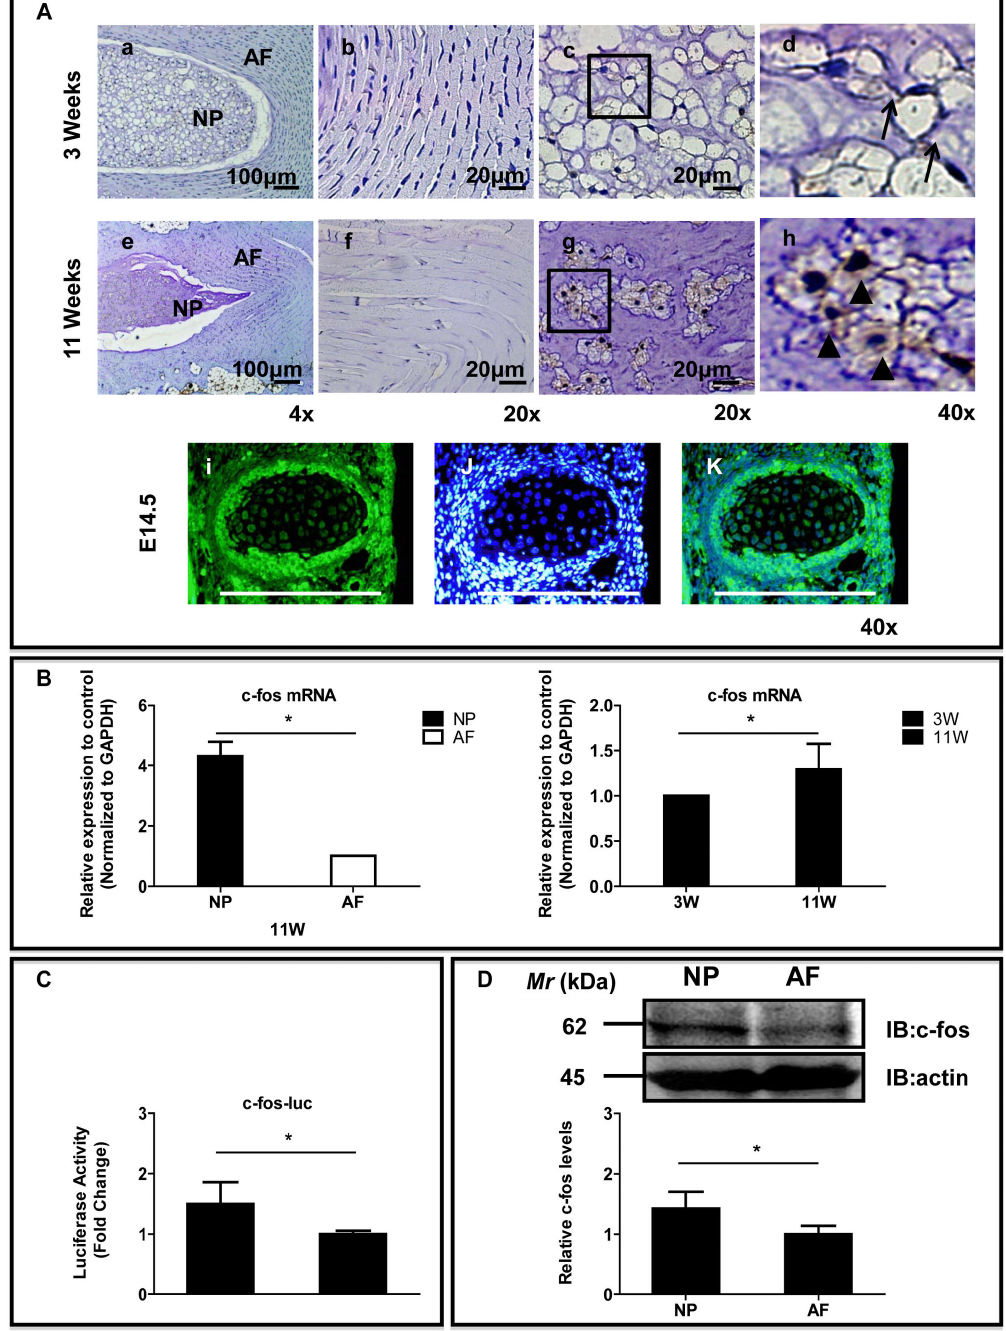
Figure 3. The expression of c-fos in IVD. ( A ) Sagittal sections from 3-week-old ( a - d ), 11-week-old ( e - h ) rats and a mouse embryo (day 14.5 of gestation). Detection of c-fos expression by immunofluorescence microscopy. b and f : AF, c- d and g- h : NP, i- k : notchordal cell of embryonic mouse ( Left : The cells stained with antibody to c-fos. Middle : The cells were stained with DAPI to identify healthy nuclei, shown in blue. Right: The cells were stained with an antibody to c-fos and with DAPI). Scale bar= 20 μm-100 μm (original magnification 4×- 40×). ( B ) Real-time RT-PCR analysis of c-fos mRNA levels in NP and AF tissue from 11-week-old rats (left panel); c-fos mRNA levels in NP tissue from 3-week-old rats and 11-week-old rats (right panel). ( C ) Basal activities of the c- fos promoter in NP cells and AF cells were determined by Dual-Luciferase assays. ( D ) Western blot analysis of c-fos expression in AF and NP cells. * P < 0.05 indicates significant differences between groups. doi: 10.1371/journal.pone.0073210.g003 PLOS ONE |